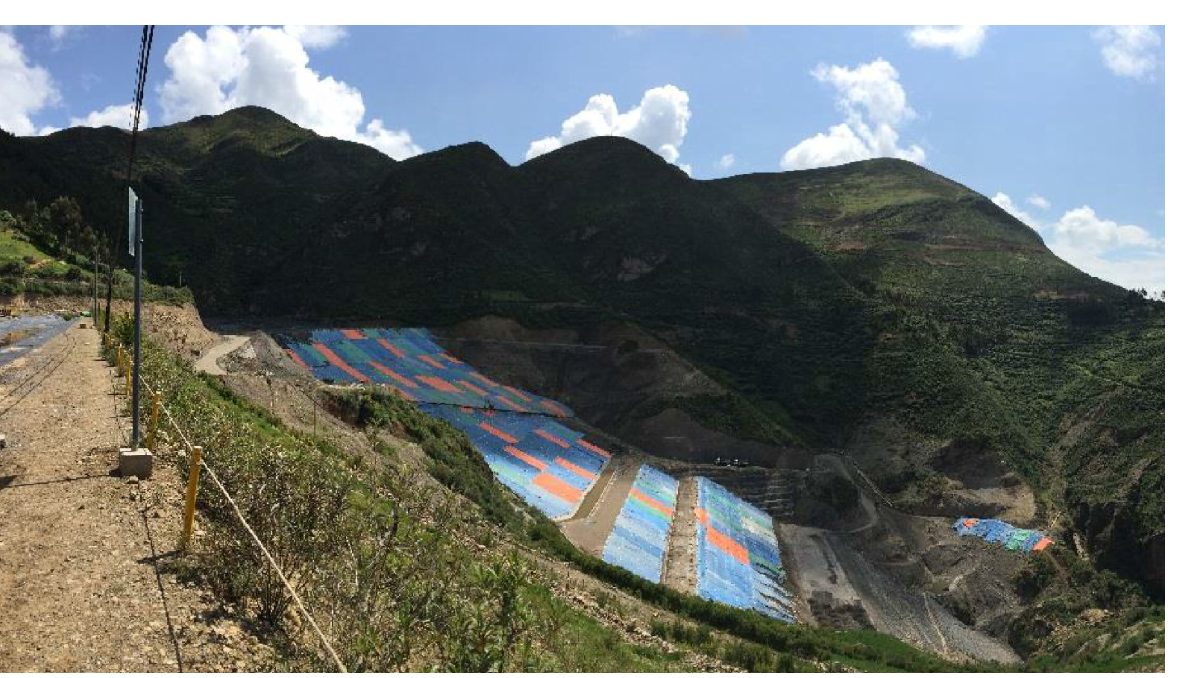
Figure 67. Ramahuayco Filtered TSF—Terraces Overview [40,41].